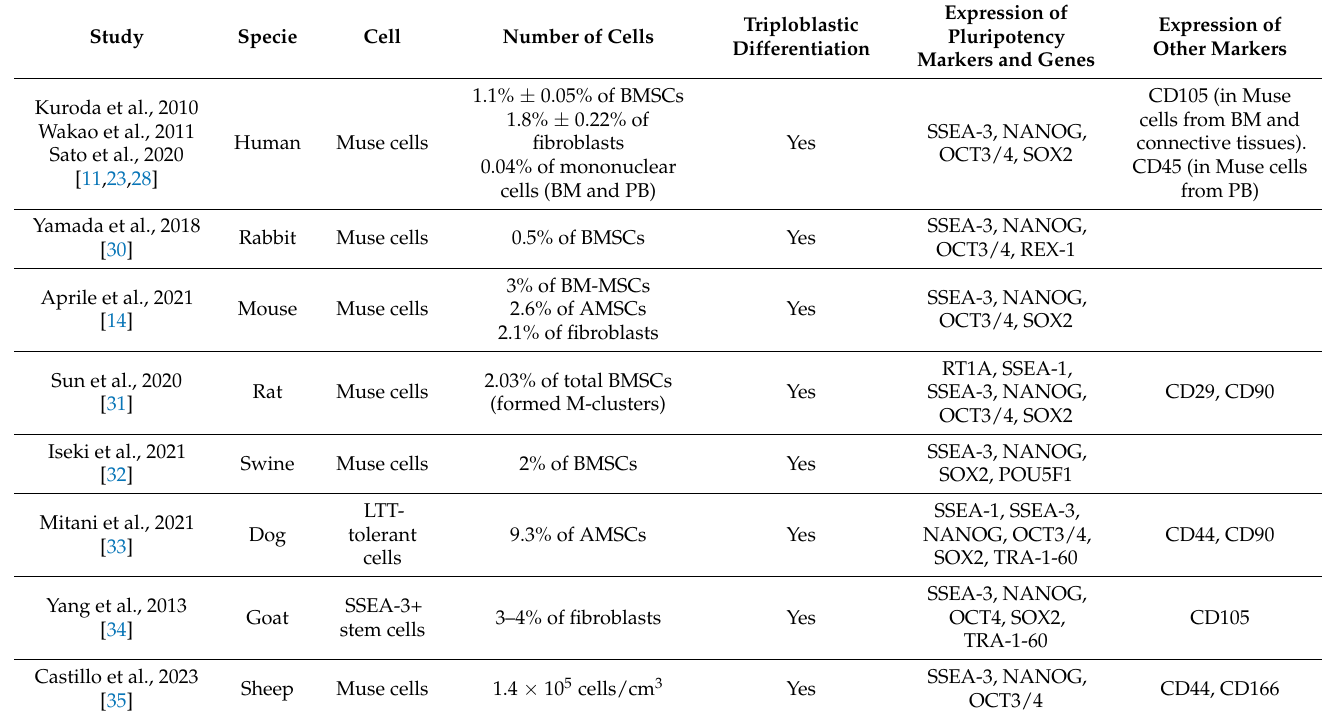
Table 1. Characterization of Muse cells and equivalent cells in different